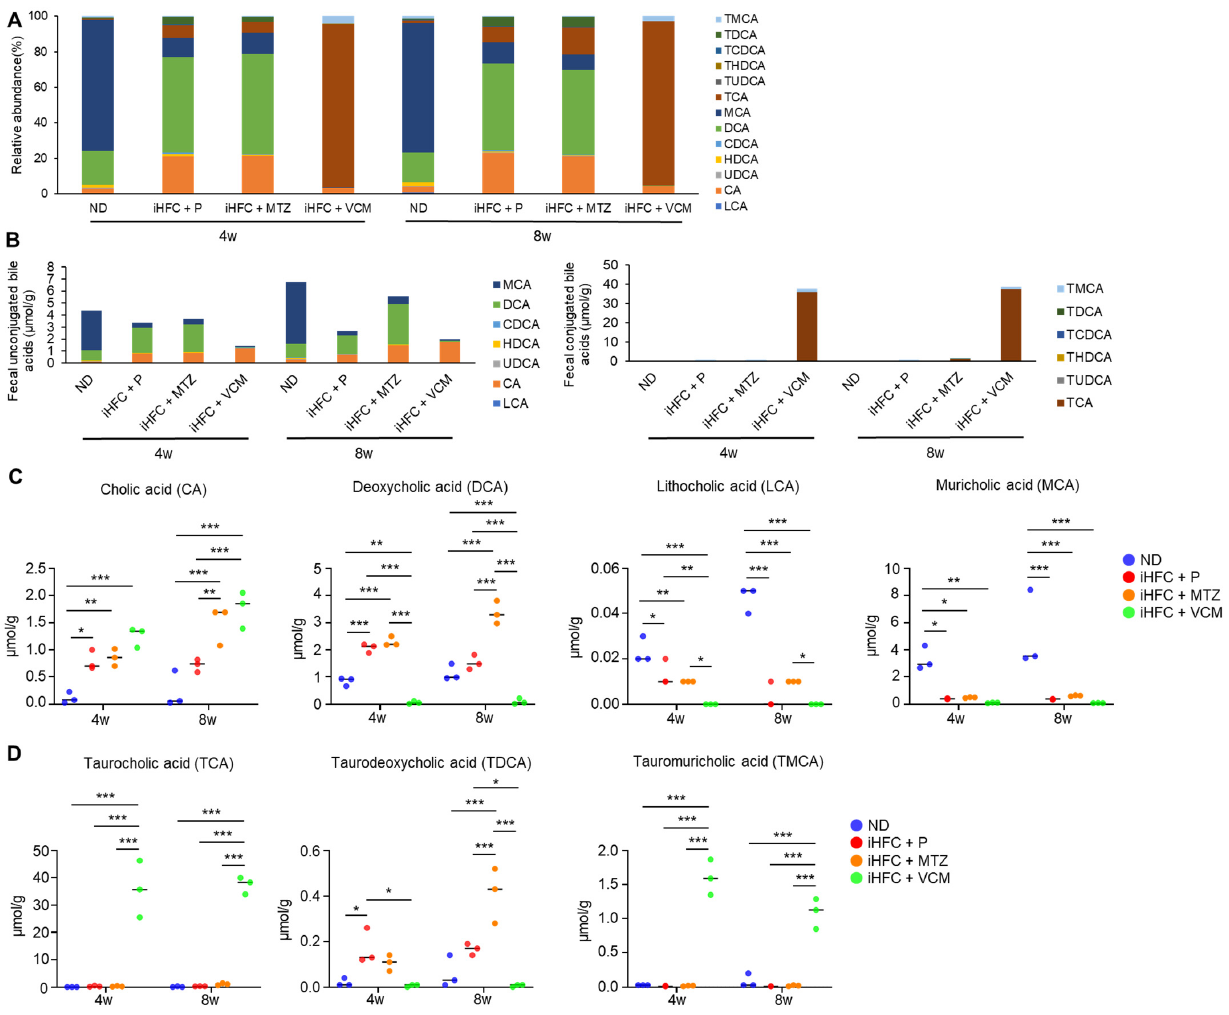
Figure 8. An iHFC diet and antibiotic treatment affect the levels of fecal BA metabolism. ( A ) Total BA composition in the feces of ND, iHFC + P, iHFC + MTZ, and iHFC + VCM groups after 4 and 8 weeks of treatment (n = 3 per group). ( B ) Concentration of unconjugated BAs (Left) and conjugated BAs (Right) in the feces of ND, iHFC + P, iHFC + MTZ, and iHFC + VCM groups after 4 and 8 weeks of treatment (n = 3 per group). ( C , D ) Changes in individual unconjugated BAs ( C ) and conjugated BAs ( D ) in the feces of ND, iHFC + P, iHFC + MTZ, and iHFC + VCM groups after 4 and 8 weeks of treatment (n = 3 per group). Data are shown as means ± SD. * p < 0.05 , ** p < 0.01, *** p < 0.001.